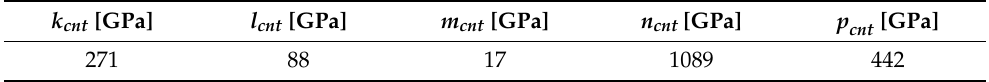
Table 1. Hill’s elastic moduli for (10, 10) single-walled carbon nanotubes